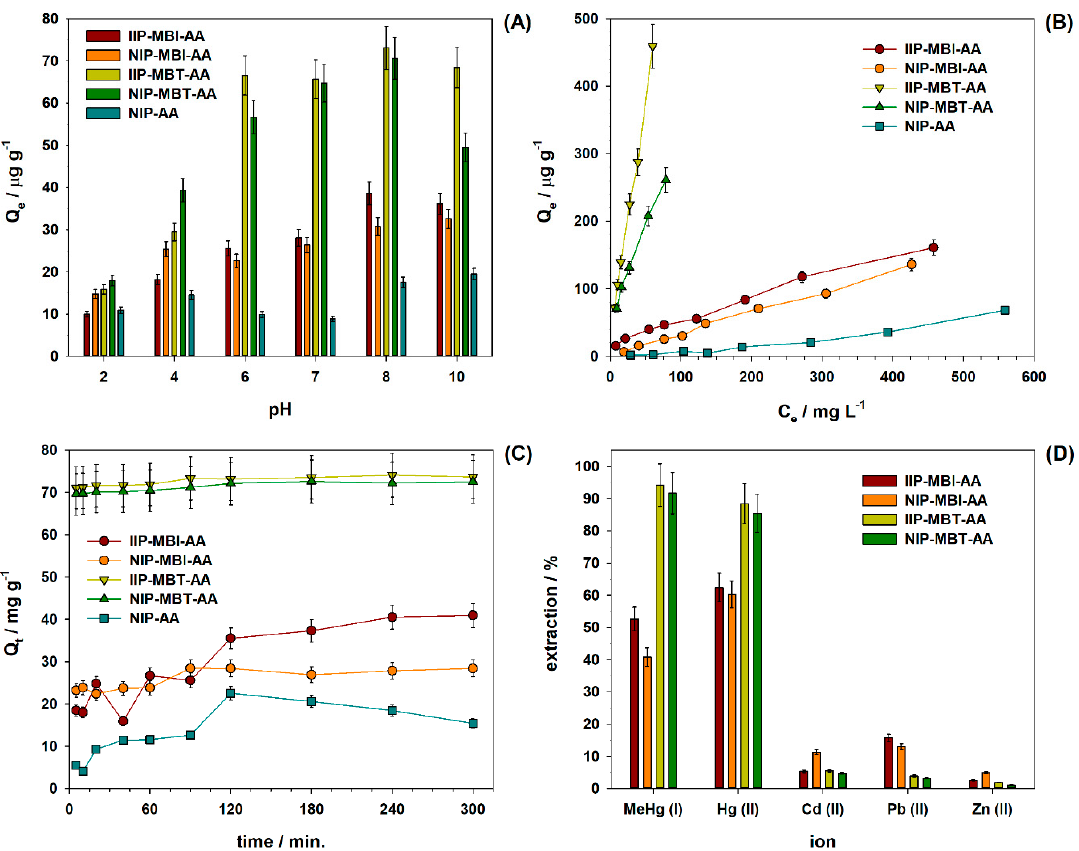
Figure 4. ( A ) E ff ect of pH on sorption of MeHg + on IIP–MBI–AA, NIP–MBI–AA, IIP–MBT–AA, Figure 4. ( A ) Effect of pH on sorption of MeHg + on IIP–MBI–AA, NIP–MBI–AA, IIP–MBT–AA, NIP– NIP–MBT–AA, and NIP–AA; 3 mg of polymeric material, [MeHg + ] = 100 µ g L − 1 , volume = 2.0 mL, MBT–AA, and NIP–AA; 3 mg of polymeric material, [MeHg + ] = 100 µg L − 1 , volume = 2.0 mL, shaking shaking time = 2 h, room temperature. ( B ) The e ff ect of MeHg + initial concentration on the adsorption of time = 2 h, room temperature. ( B ) The effect of MeHg + initial concentration on the adsorption of MeHg + on IIP–MBI–AA, NIP–MBI–AA, IIP–MBT–AA NIP–MBT–AA, and NIP–AA; 3 mg of polymeric MeHg + on IIP–MBI–AA, NIP–MBI–AA, IIP–MBT–AA NIP–MBT–AA, and NIP–AA; 3 mg of material, [MeHg + ] = 25–800 µ g L − 1 , pH = 8, volume = 2.0 mL, shaking time = 2 h, room temperature. polymeric material, [MeHg + ] = 25–800 µg L − 1 , pH = 8, volume = 2.0 mL, shaking time = 2 h, room ( C ) Kinetics of MeHg + adsorption on IIP–MBI–AA, NIP–MBI–AA, IIP–MBT–AA NIP–MBT–AA, temperature. ( C ) Kinetics of MeHg + adsorption on IIP–MBI–AA, NIP–MBI–AA, IIP–MBT–AA NIP– and NIP–AA; 3 mg of polymeric material, [MeHg + ] = 100 µ g L − 1 , pH = 8, shaking time = 5–300 min, volume = 2.0 mL, room temperature. ( D ) The selectivity profiles of the IIPs and NIPs for binary mixtures containing MeHg + and potential interferents. In all experiments n =